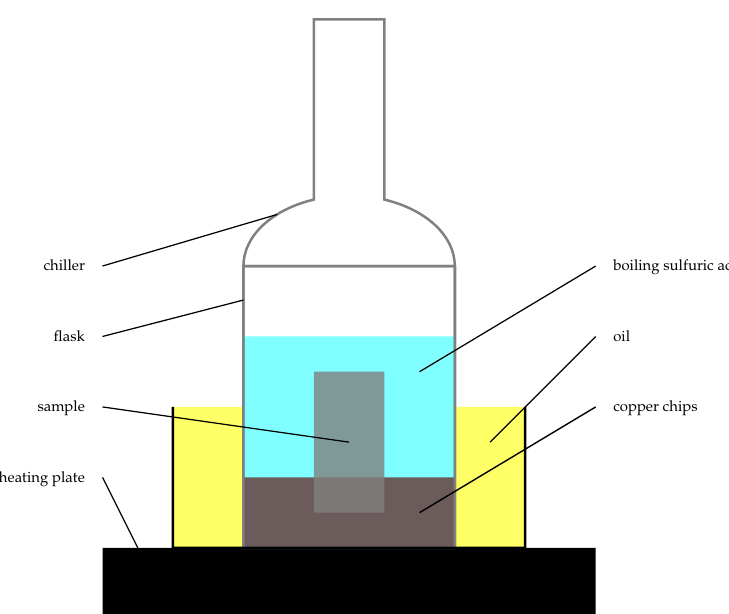
Figure 4. Schematic representation of the setup used for IGC testing of FSS.